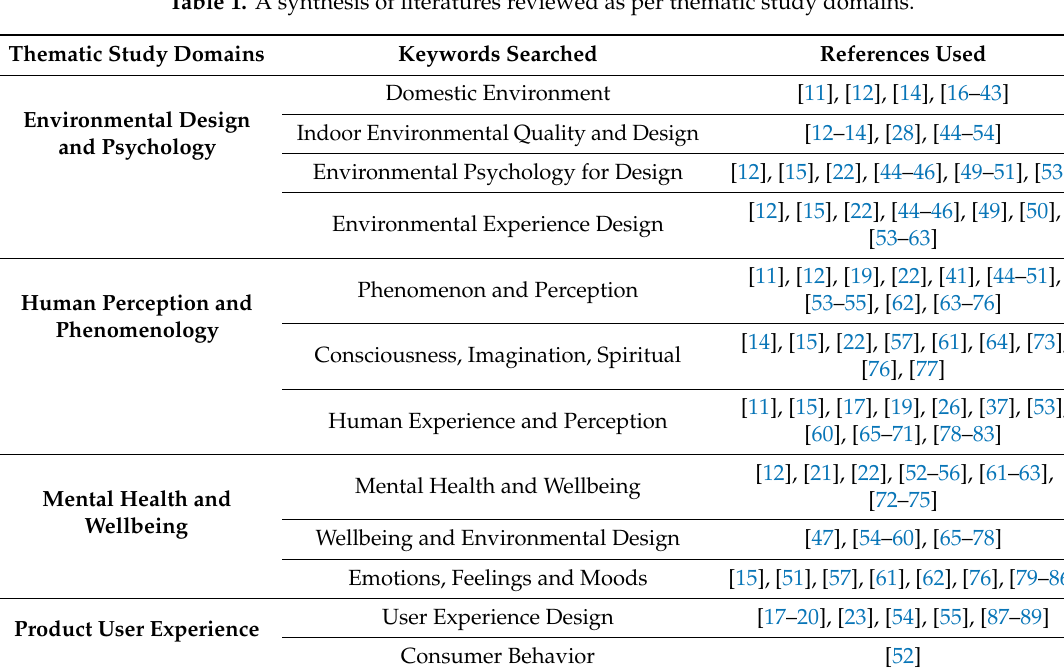
Figure 1. Thematic study domains identified. Table 1. A synthesis of literatures reviewed as per thematic study